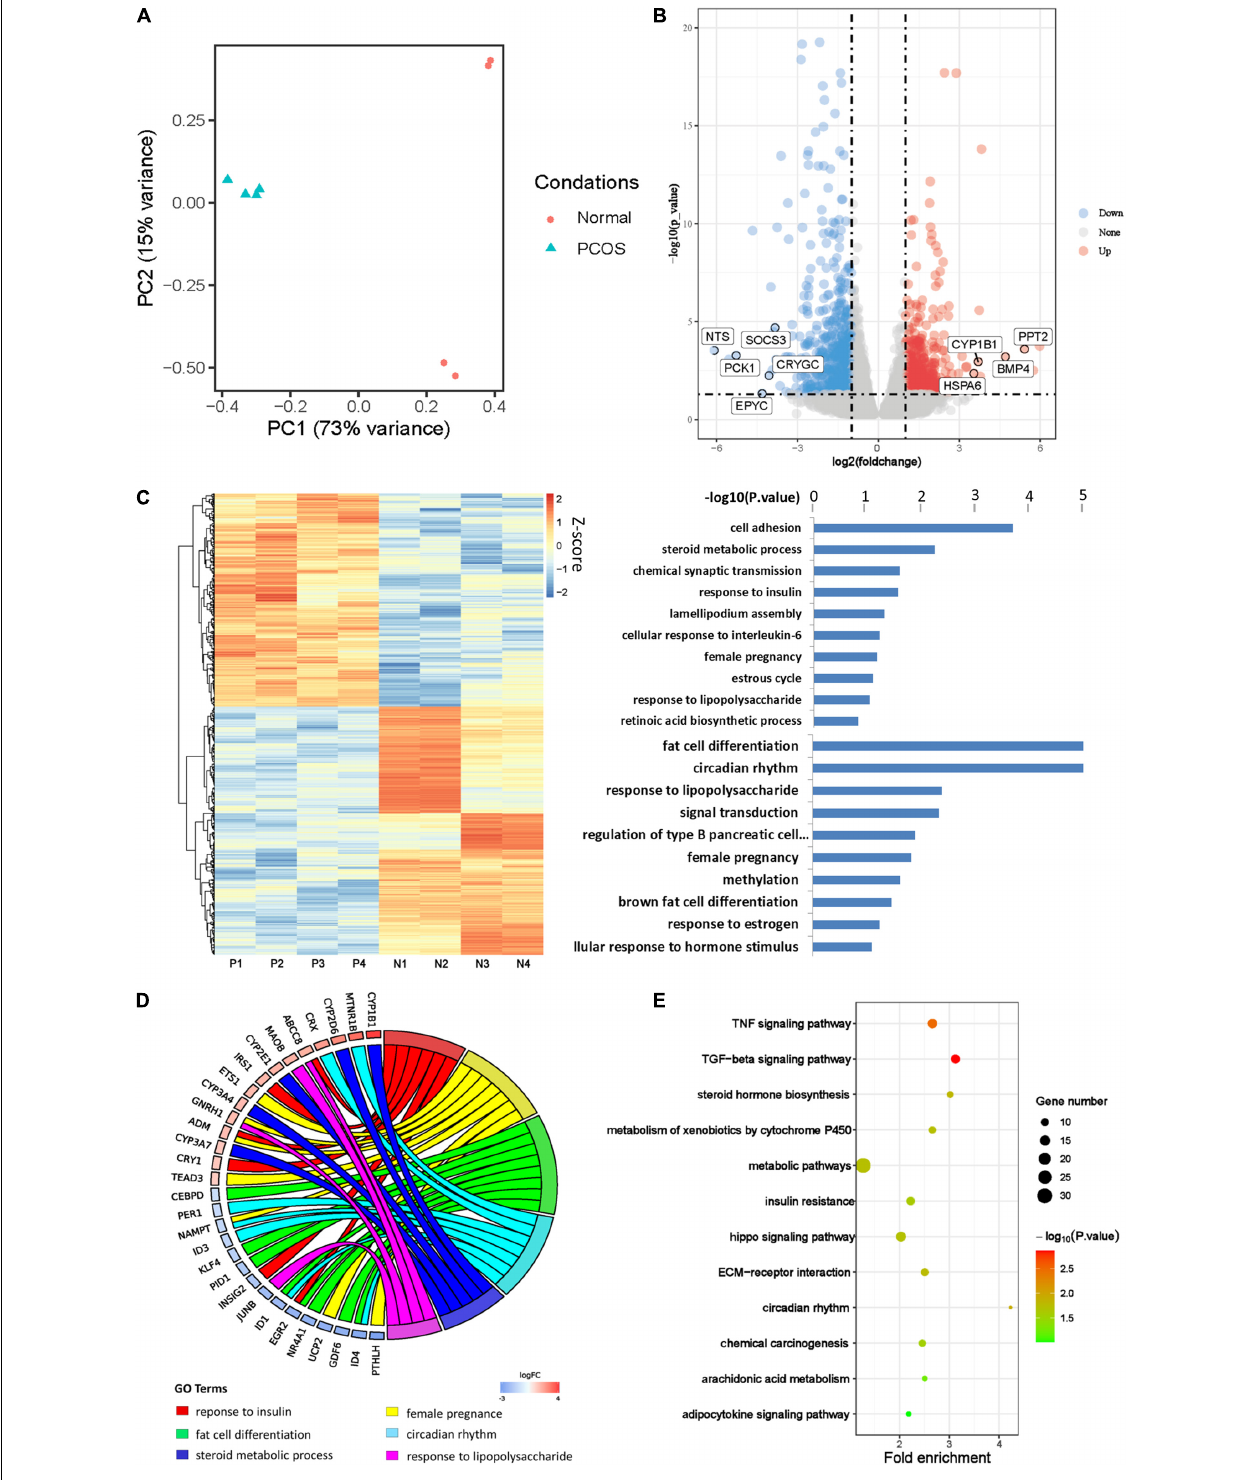
FIGURE 1 | Transcriptional profile of human PCOS. (A) Principal component analysis (PCA) of global transcriptomes in GCs obtained from PCOS and control ovaries. The samples are represented by different colors as indicated in the right. (B) Volcano plot showing differentially expressed genes (DEGs) obtained by a pairwise comparison between PCOS and control GCs. Upregulated and downregulated genes were colored in red and blue, respectively. (C) Analysis of PCOS transcript profiles and genes function. (D) The GO chord showing the biological processes and genes that participate in PCOS. (E) KEGG analysis of differentially expressed genes between PCOS and